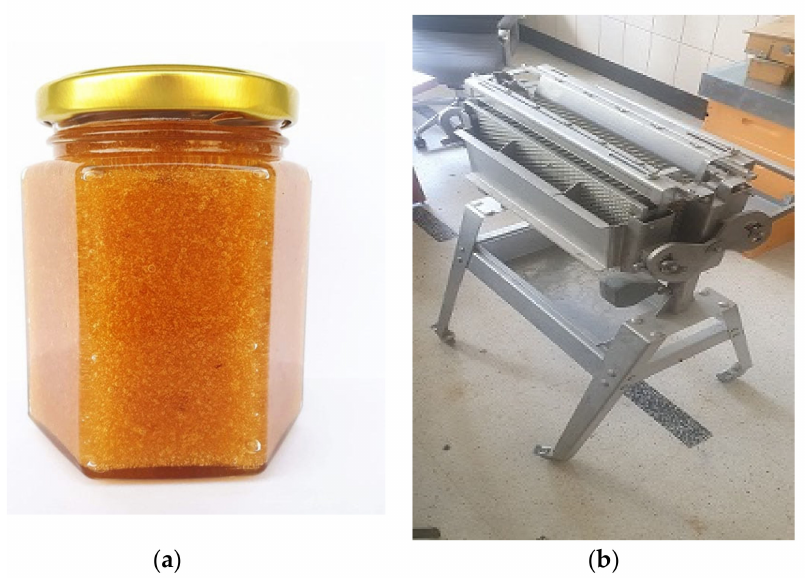
Figure 3. ( a ) Heather honey (S ă b ă du¸s Ioan, beekeepr—personal collection), and ( b ) heather honey extractor (Beekeeping and Sericulture Department, Faculty of Animal Science and Biotechnology, UASVM Cluj-Napoca, Romania).